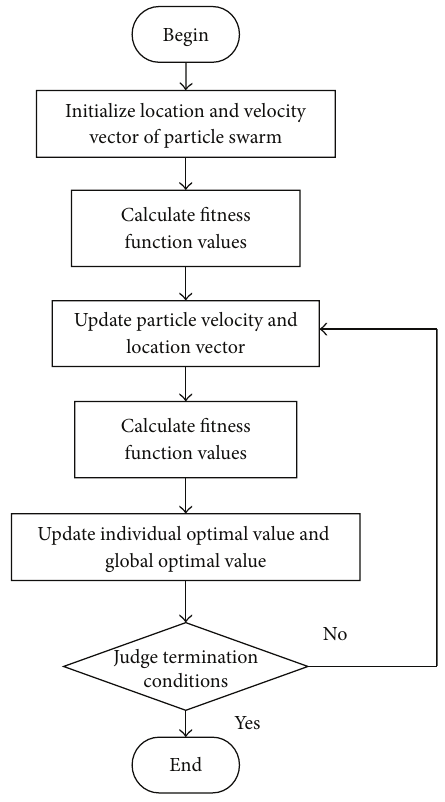
Figure 8: Flowchart of PSO